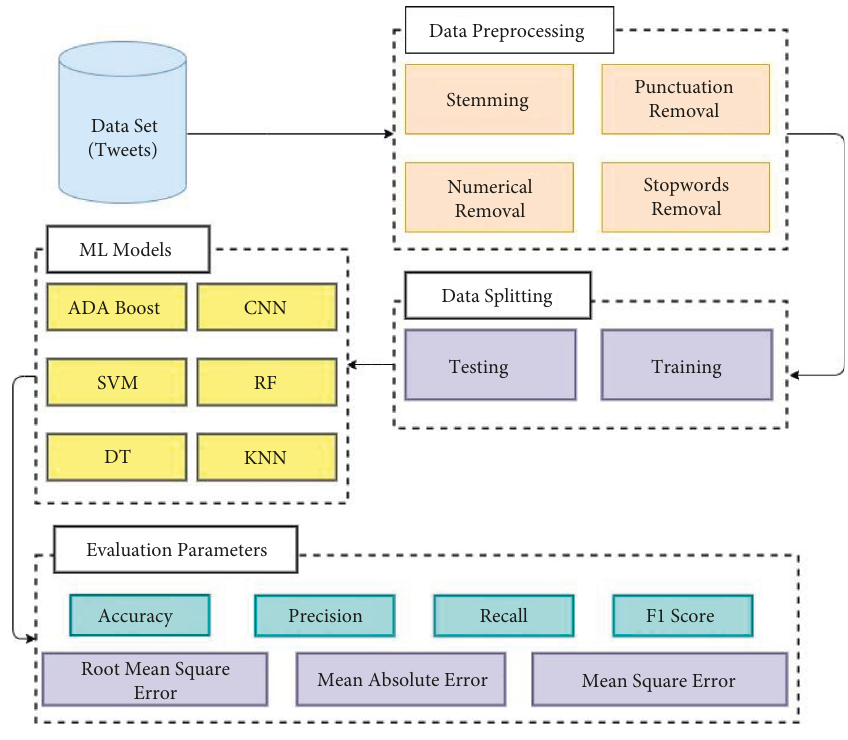
Figure 2: Methodology